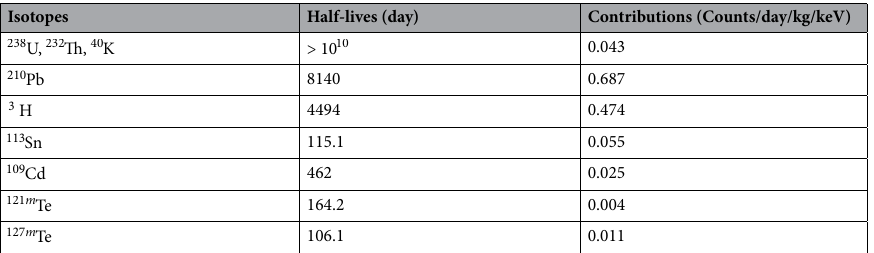
Table 4. Time-dependent background contributions in the NaI(Tl) crystals. The model of DAMA/LIBRA background model, assuming COSINE-100’s background composition is summarized with half-lives and initial background contributions in the 2–6 keV single-hit